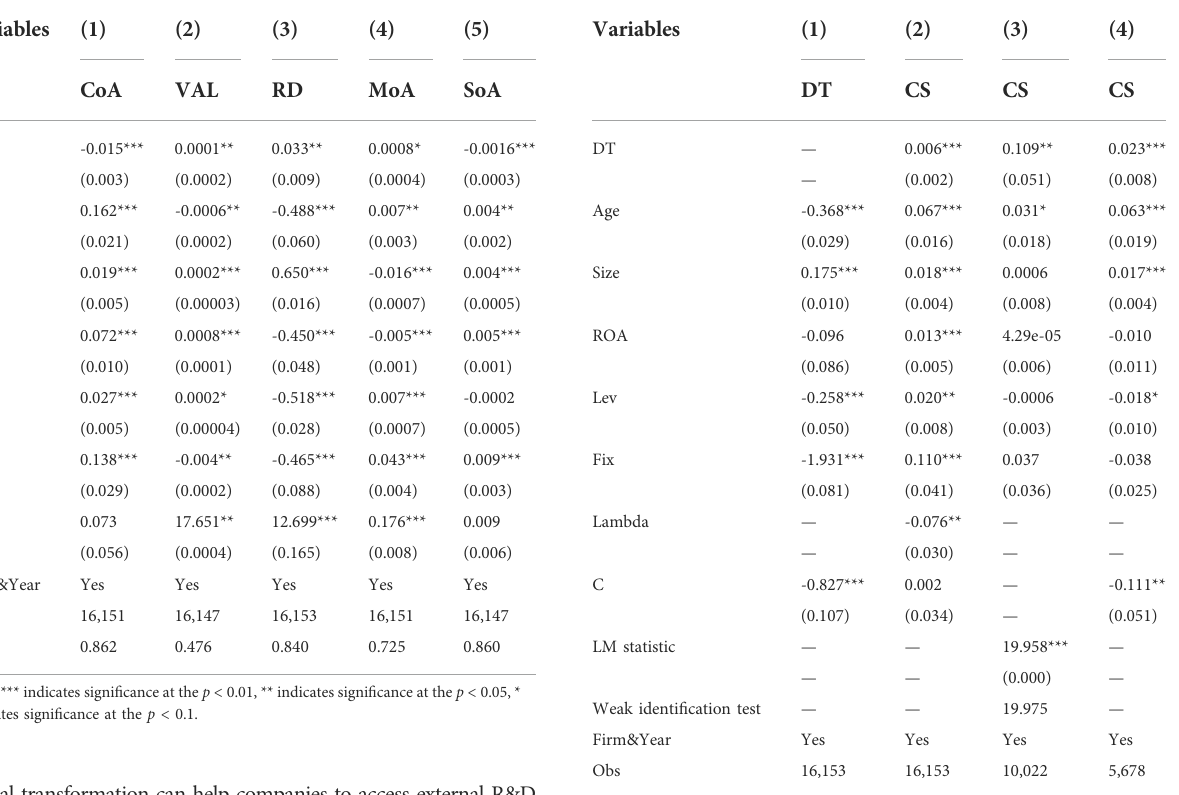
TABLE 5 Selection bias and endogeneity issues. TABLE 4 Analysis of